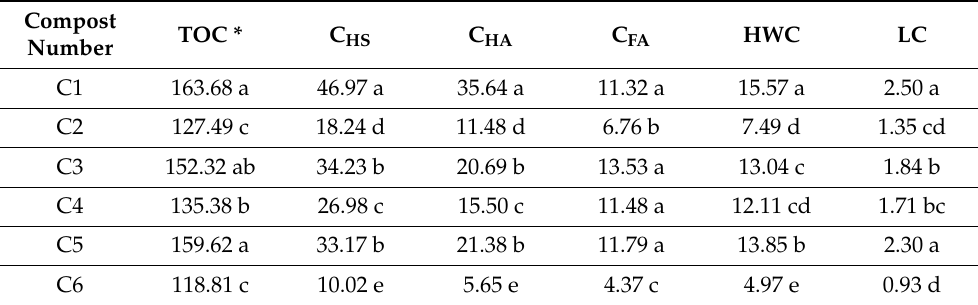
Table 4. Total, labile, hot water-extractable carbon content, and amounts in humic substances of composts (g · kg − 1 ).